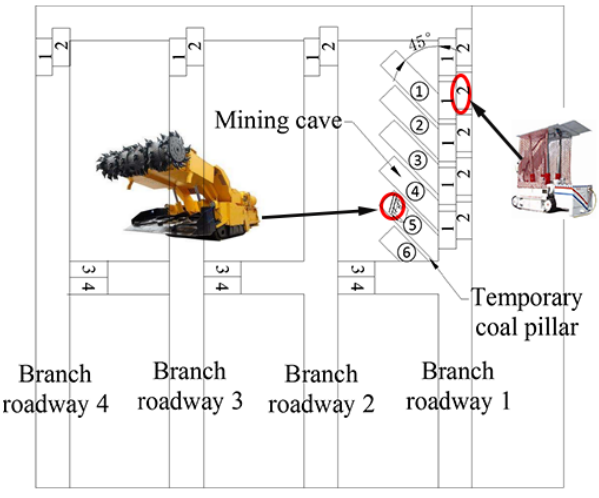
Figure 2. Illustration of the recovery process of coal pillars and main equipment.